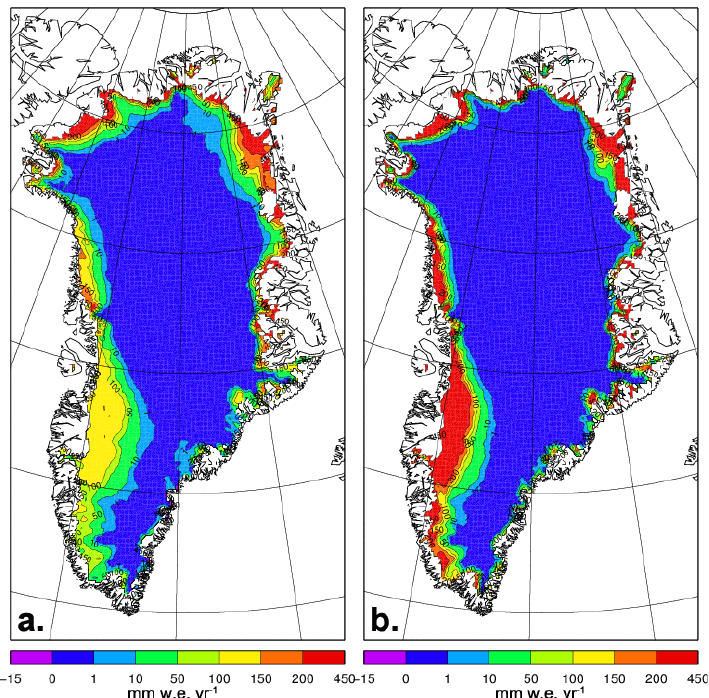
Fig. 9. Difference in refreezing when varying the depth of the thermally active layer ( d ice ) in JH2000 (Eq. 5). (a) d ice = 2m minus C , (b) d ice = 5m minus 2m, using RACMO2 input